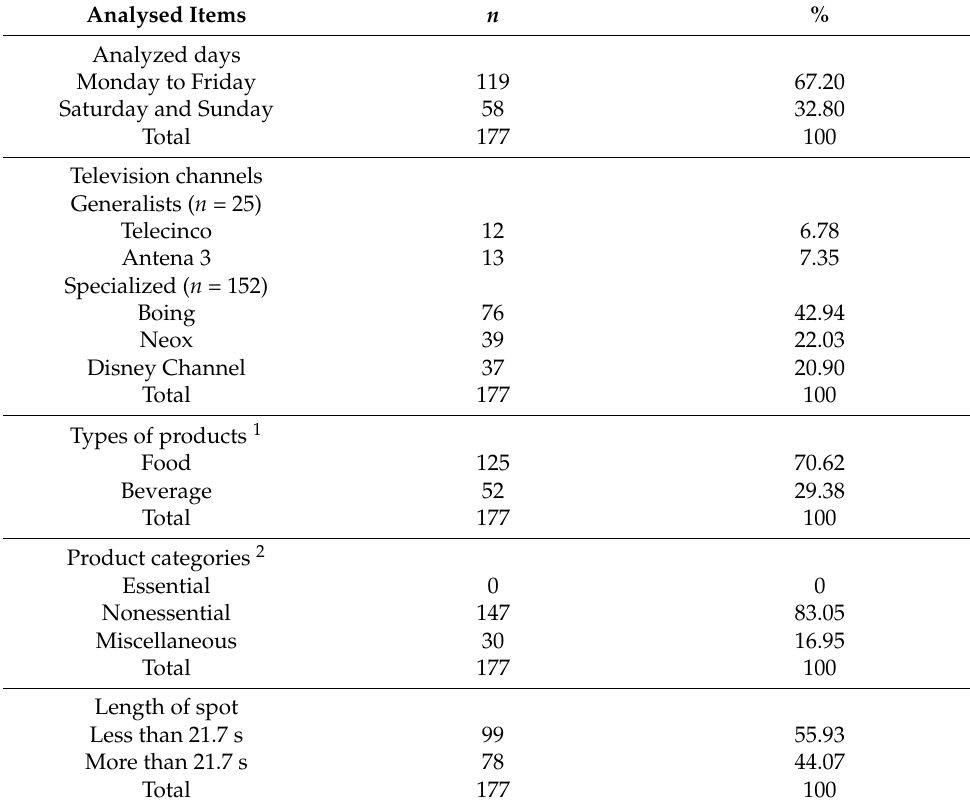
Table 1. Frequency of food and drink advertising for the under-12s in our sample population; by days of the week and TV channels, type of products, product categories and duration of the